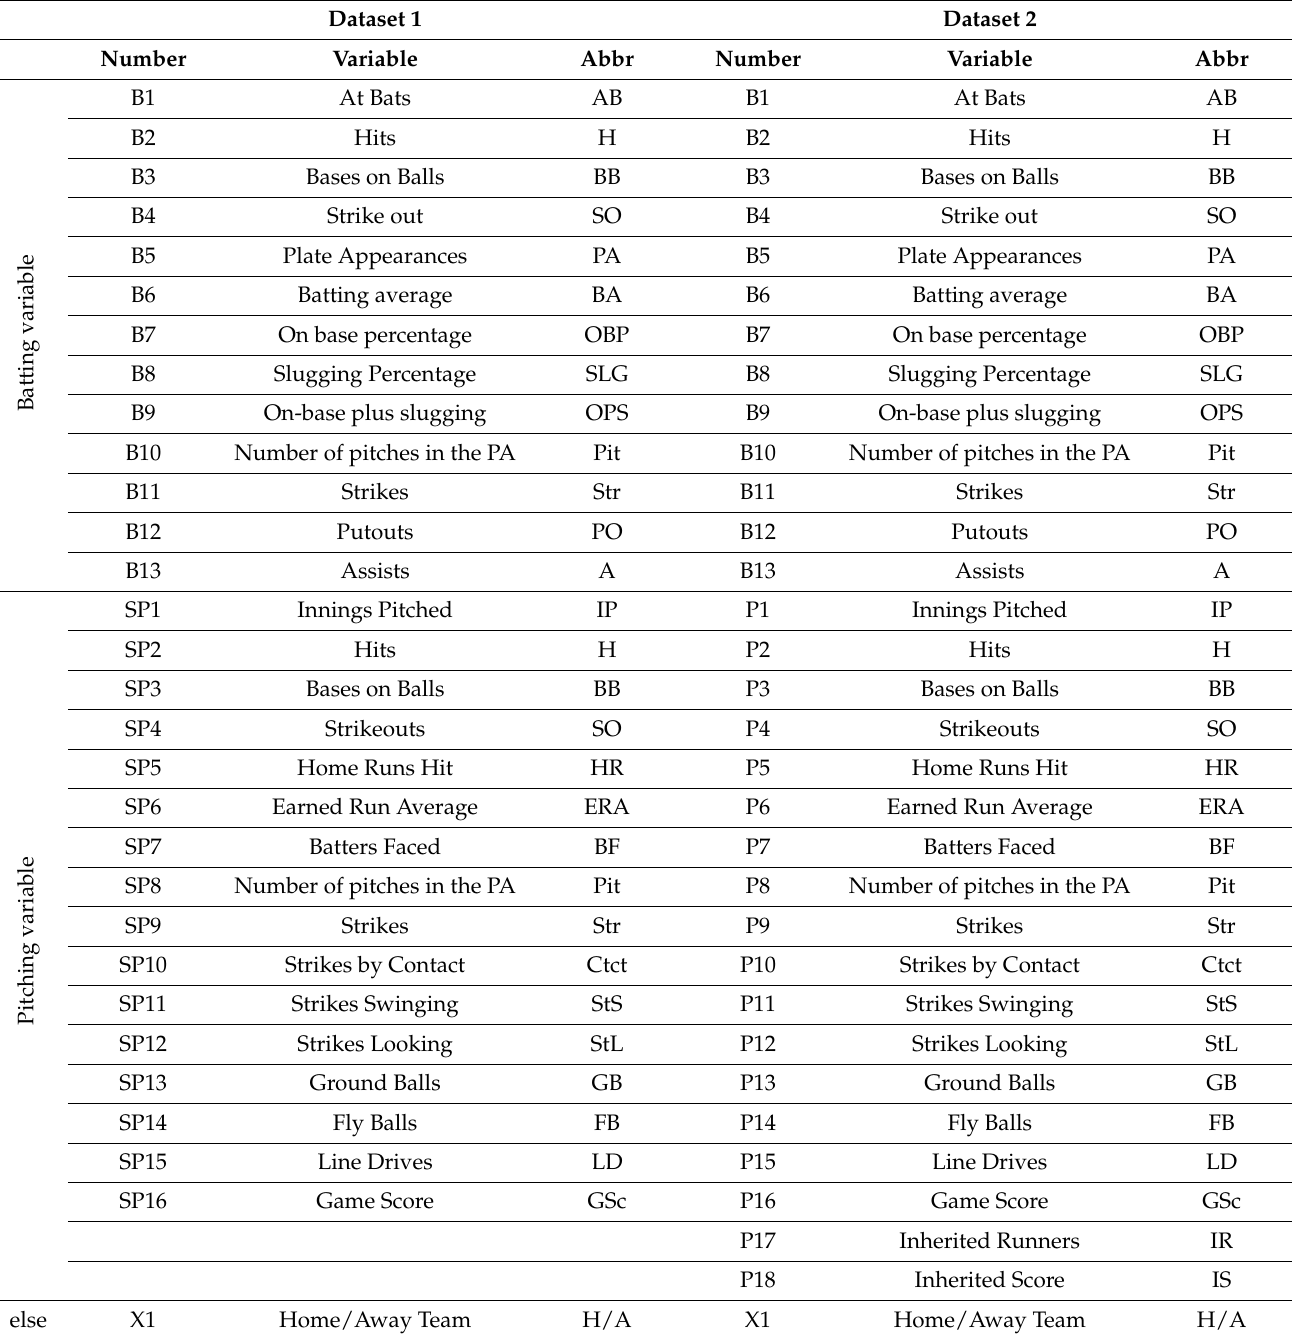
Table 1. MLB input